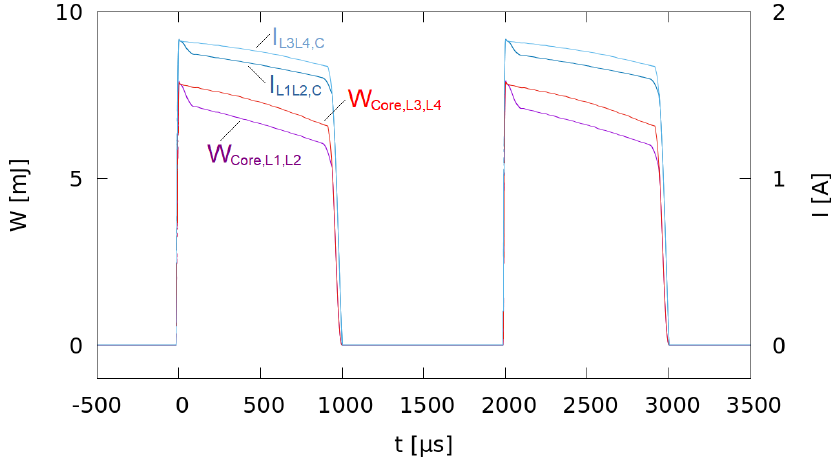
Figure 7. Energy stored in the core of two current-compensated chokes (W Core ) and common-mode current I CM through the chokes (Simulation for current-compensated chokes comprising L1, L2 and L3, L4 according to Figure 3, R D : open circuit, t on = 22 µs).